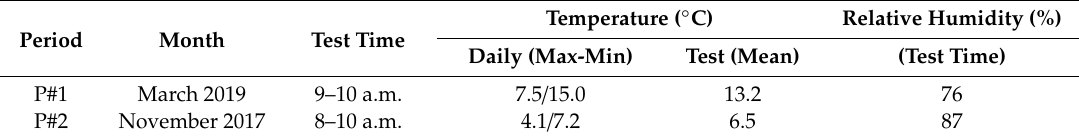
Table 1. Reference configurations for the field vibration tests.